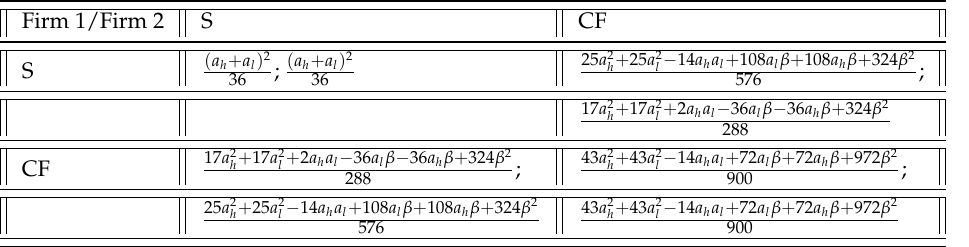
Figure A1. Matrix of payoffs with uncertain demand.